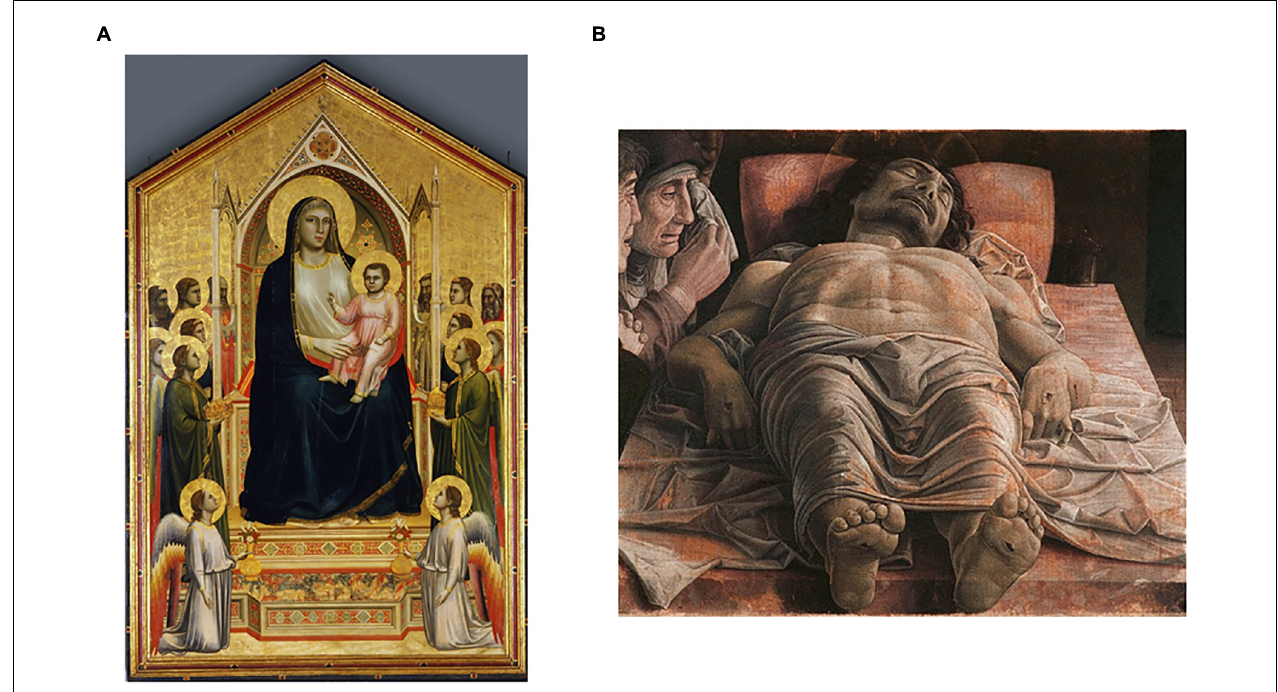
FIGURE 3 | The amount of information in paintings increased through deliberate effort from the middle ages to the renaissance. (A) Madonna and Child, Giotto di Bondone, 1320. (B) The Lamentation Over the Dead Christ, Andrea Mantegna, 1490. These paintings were obtained from public domain sites in the internet with links: https://upload.wikimedia.org/wikipedia/commons/e/e3/Giotto_di_Bondone_090.jpg and